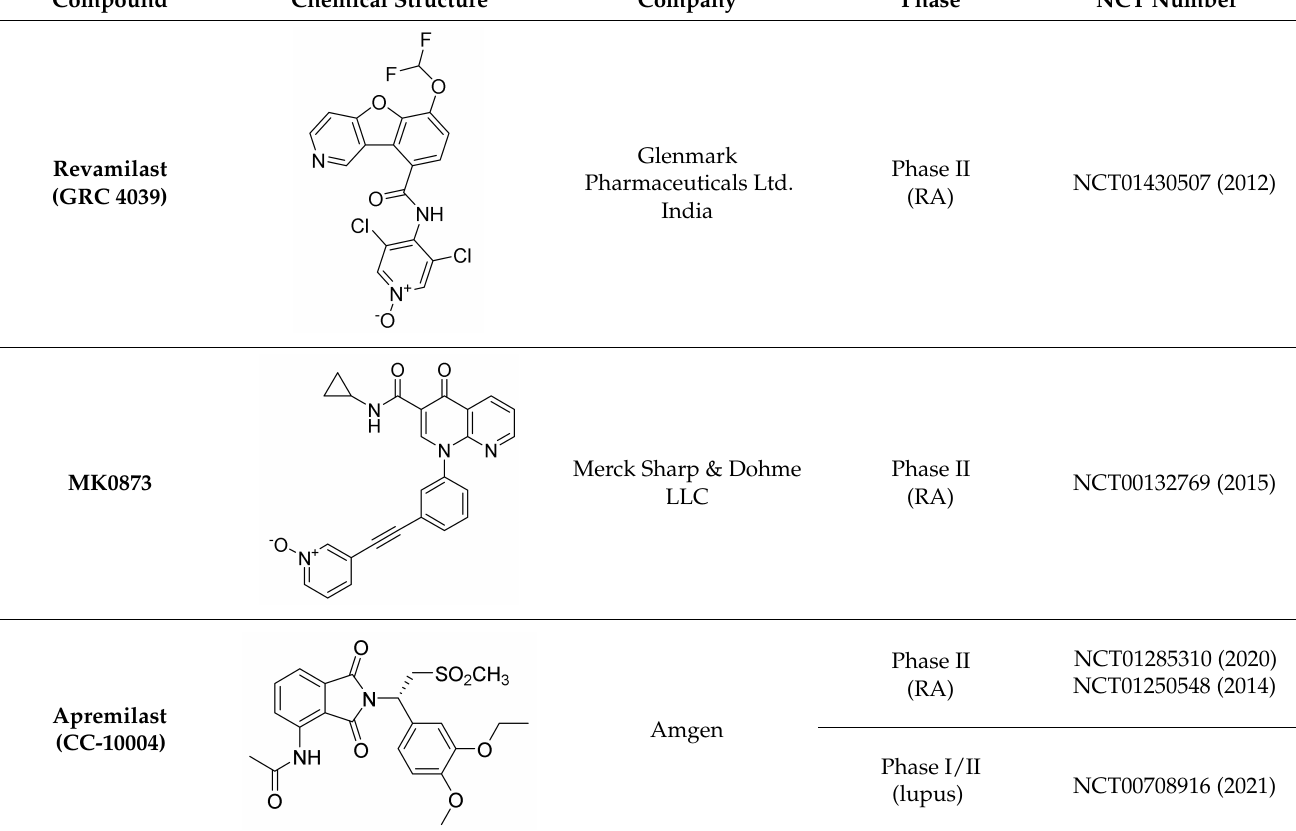
Table 3. PDE4 inhibitors under development for the treatment of rheumatoid arthritis (RA) and lupus.